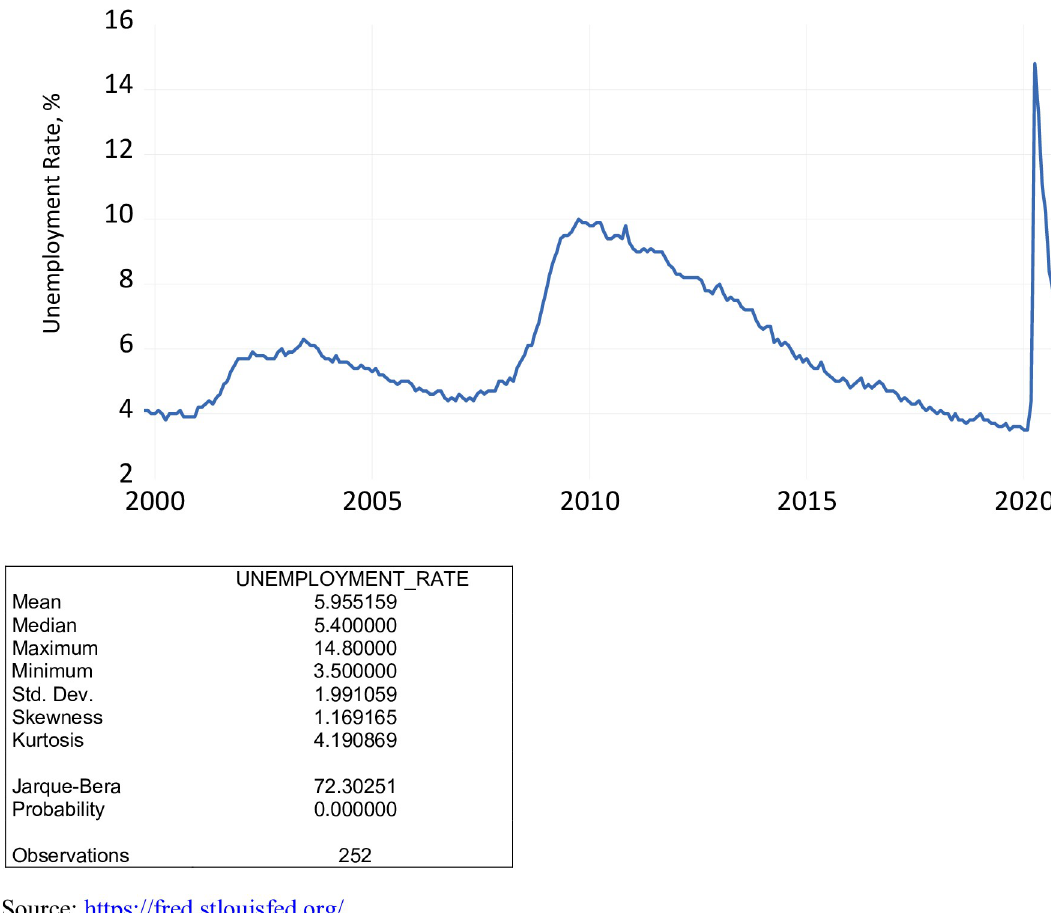
Fig 5. The unemployment rate, percent, October 1999 to September